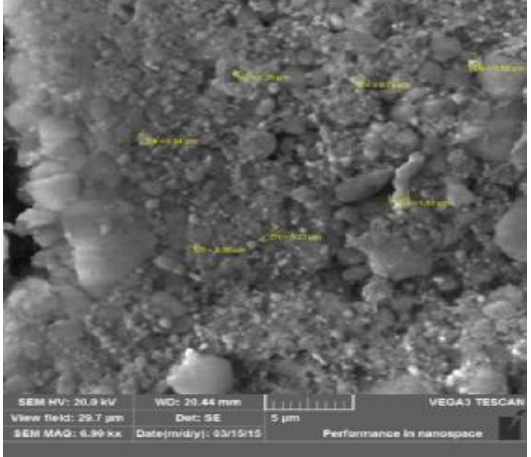
Figure2: SEM for Coated Plate Measures some of Particle